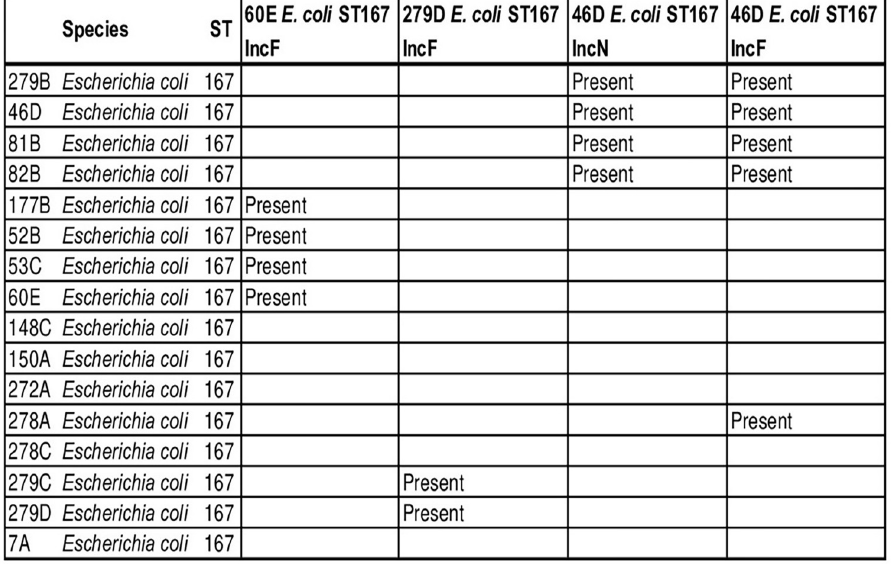
Fig 10. Screening of the four reconstructed plasmids within E . coli ST167